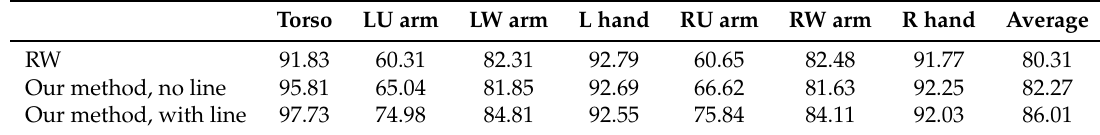
Table 1. Dataset 1 [4]: mean Jaccard index in % over all frames. U, upper; W, lower.